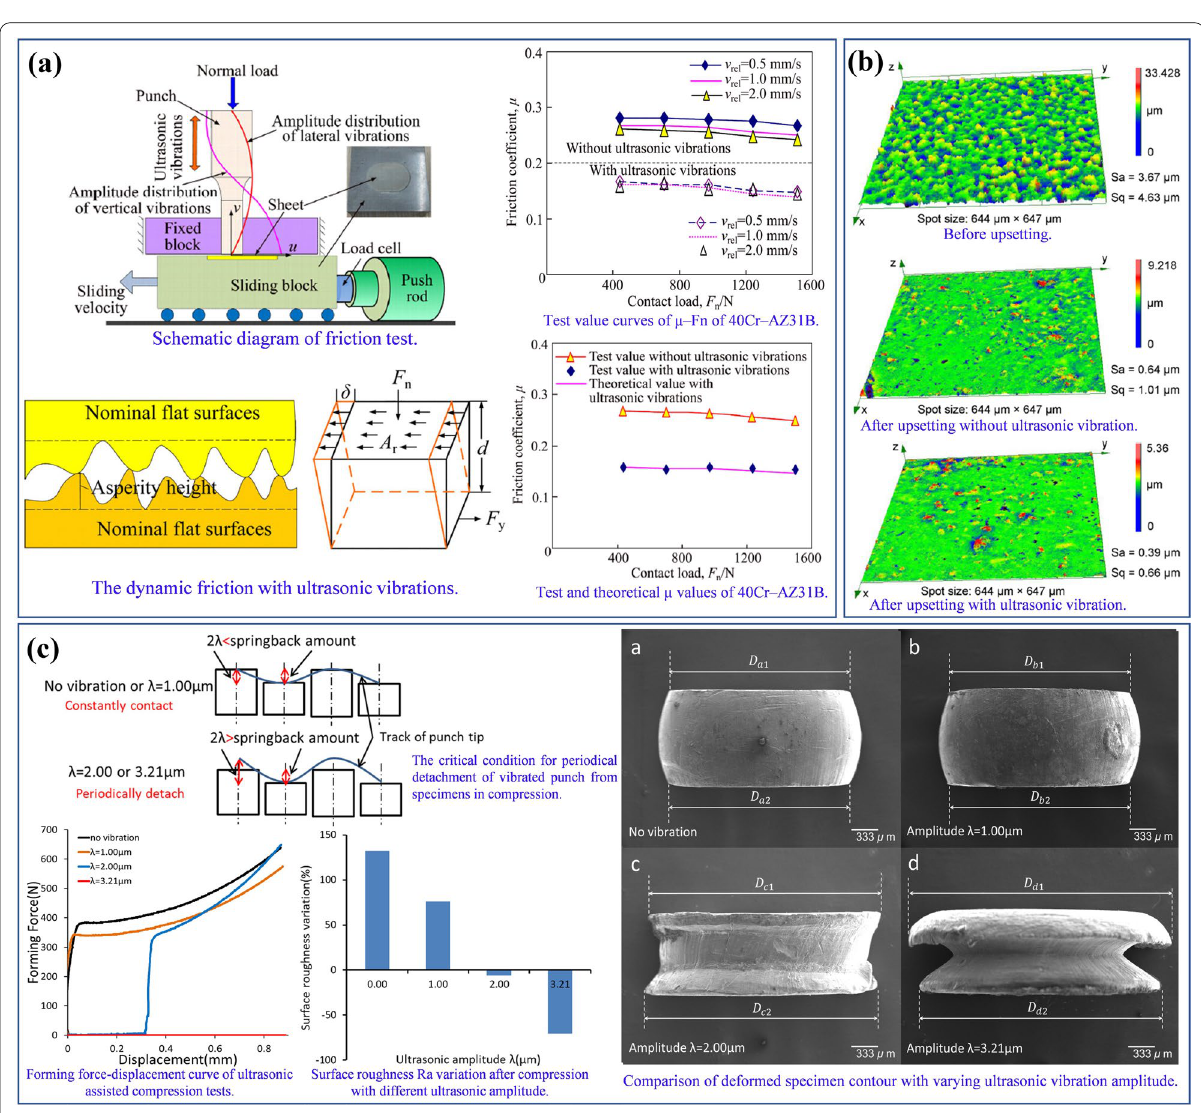
Figure 5 Surface effect of UV: a the mechanism of normal UV on friction and wear [45], b effect of UV on surface topography in micro-upsetting experiment of aluminum [17], c effect of ultrasonic dynamic impact during compression